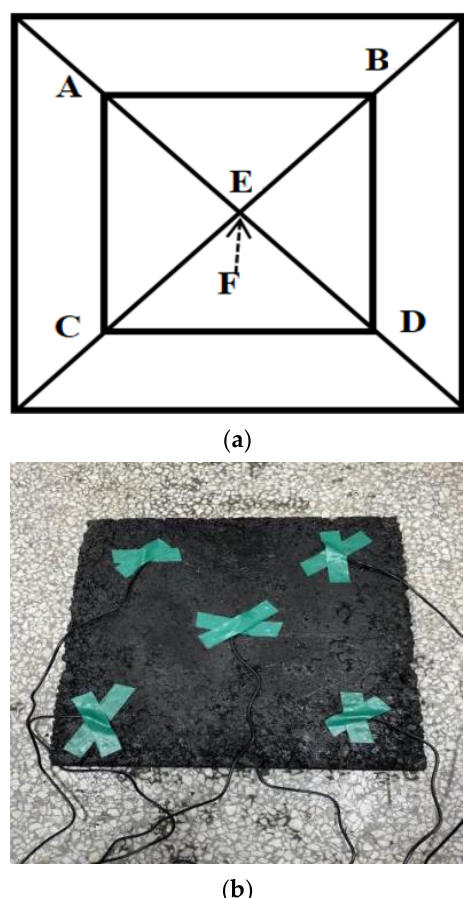
Figure 19. Temperature measuring point distribution of rut plate specimen in temperature rise test. ( a ) Diagram of distribution of temperature measuring points, ( b ) Temperature measuring point distribution of rutting plate.